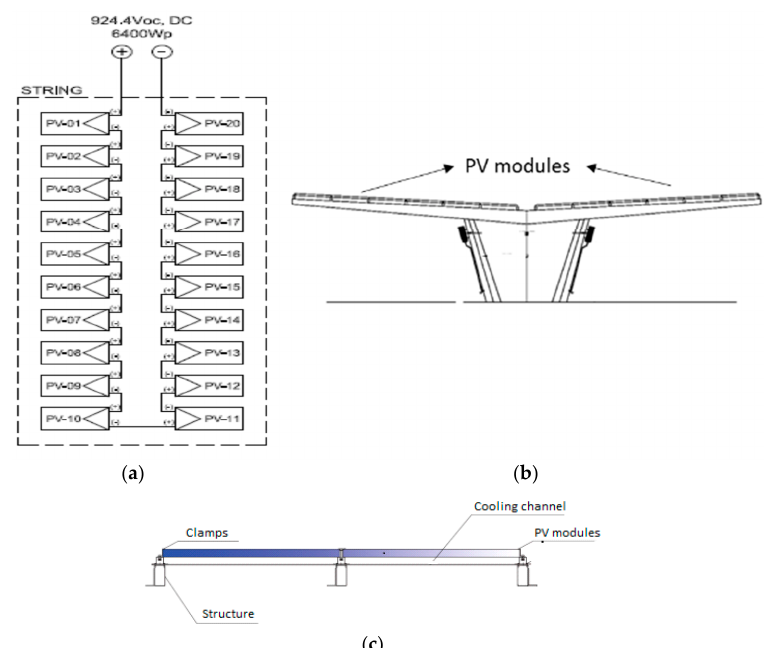
Figure 2. ( a ) Module string single line diagram; ( b ) schematic of the studied system; and ( c ) typical PV module installation. Details of the main components of the PV and the inverters are shown in Tables 1 and 2, respectively. The installed PV modules are of dimensions 0.99 m × 1.96 m, with a rated power of 320 W at standard test conditions (STC), and a module conversion efficiency of 16.51%. The panels have temperature coefficient for a maximum power of − 00.410%/°C. The electrical inverters capacities of 60 kW each. Table 1. Electrical characteristics of JAP6-72-320/4BB photovoltaic (PV) module. Specification